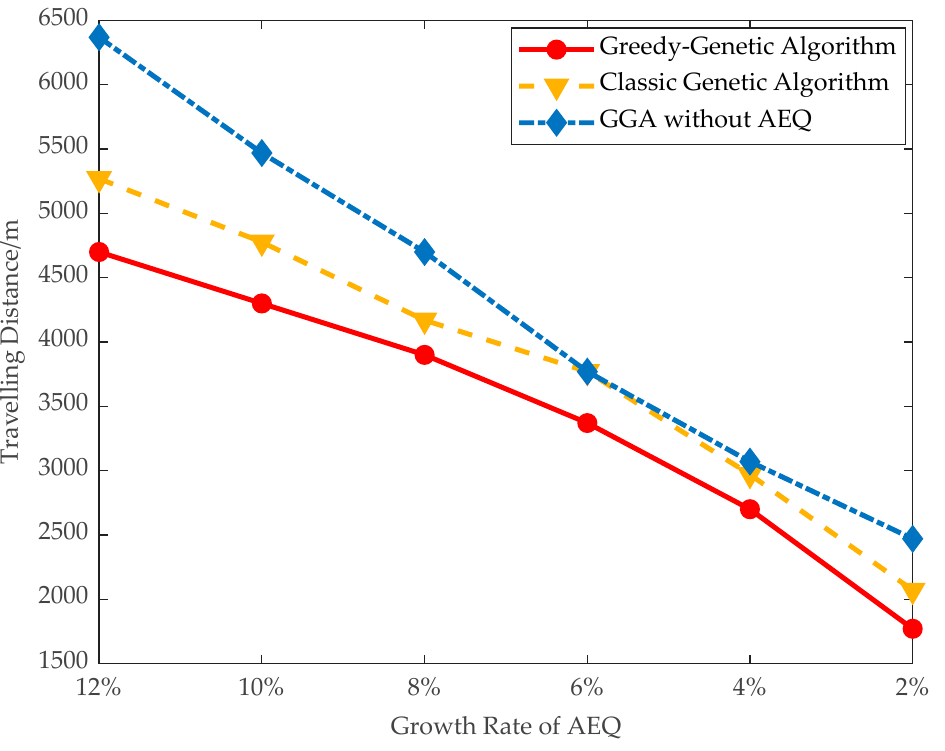
Figure 13. Travelling distance of the charger.